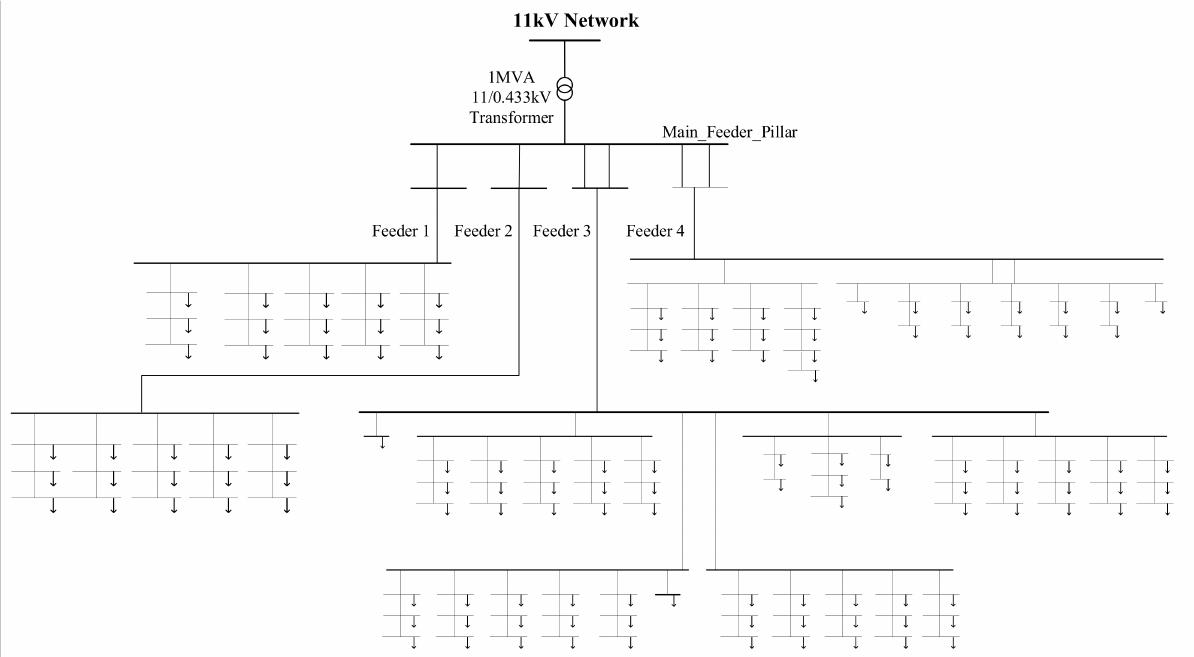
Figure 6. Single-line diagram of the test network.